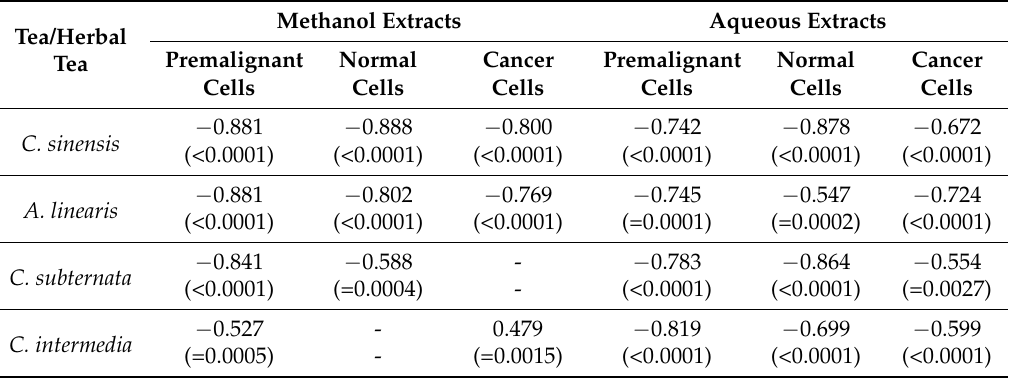
Table 4. Correlation between caspase-3 activity and cell viability (ATP production) for cells treated with green tea and herbal tea